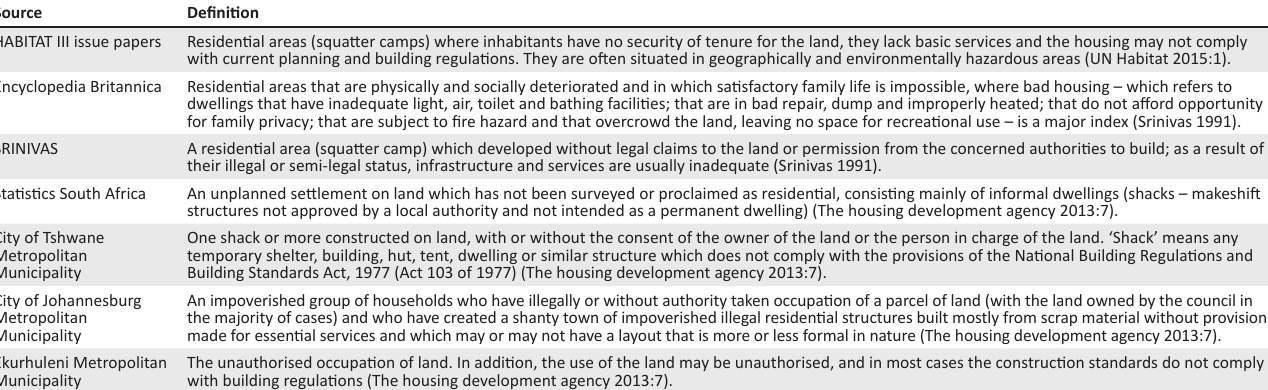
TABLE 1: Definitions of informal settlements.